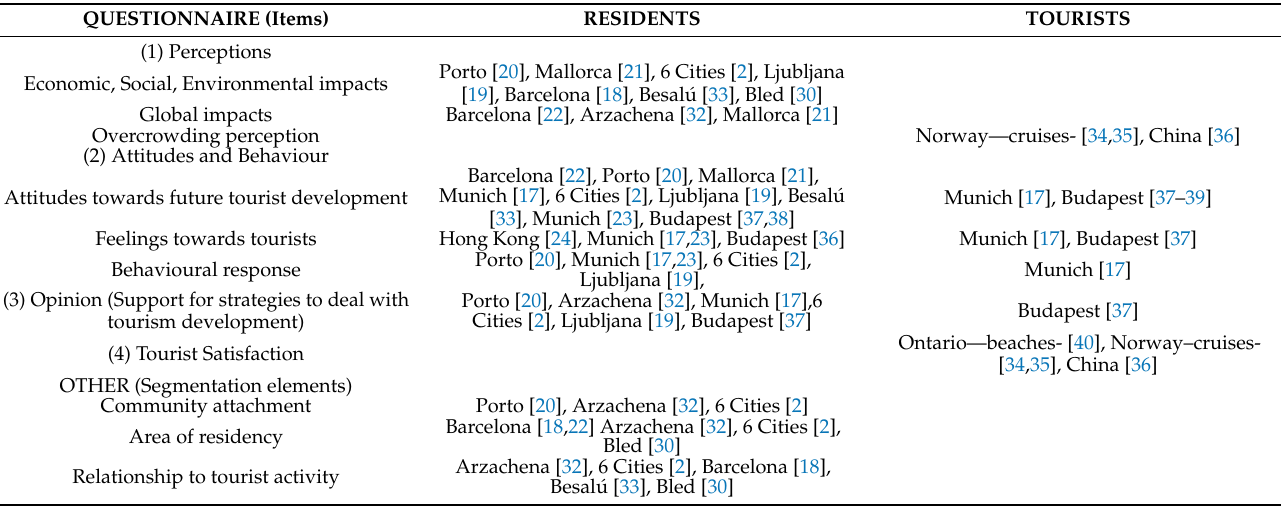
Table 2. Measuring overtourism through surveys: literature